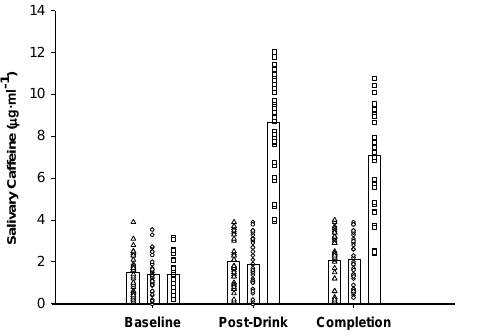
Figure 3. Mean and individual salivary caffeine responses during control (CON) ( ), placebo (PLA) ( ) and coffee (COF) ( □ ) during the 5 km cycling time trial.